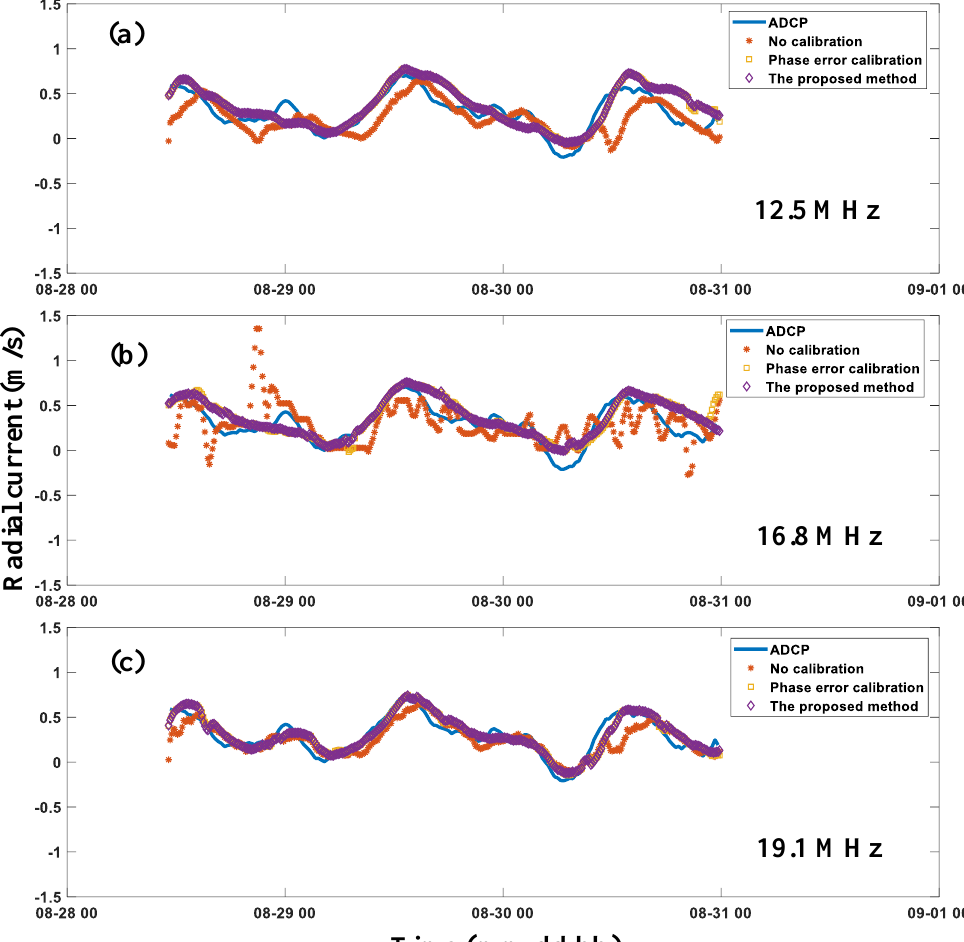
Figure 11. Comparisons between the MHF radar-derived radial currents and ADCP data. ( a ) 12.5 MHz; ( b ) 16.8 MHz; ( c ) 19.1